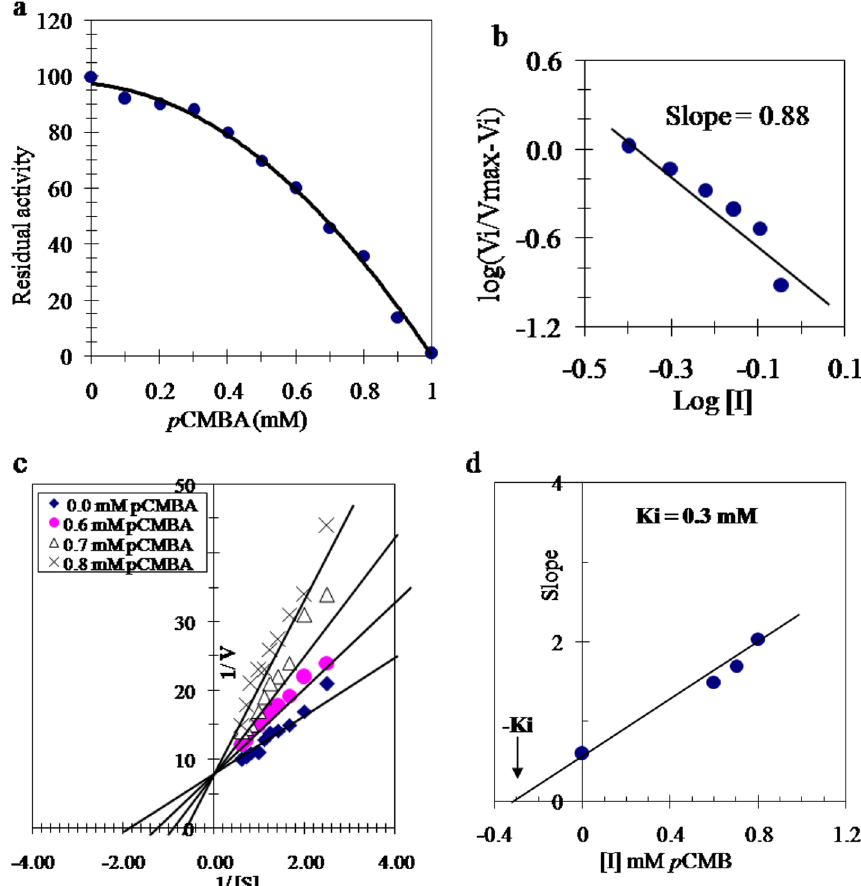
Fig. 4 a TLGST Inhibition with p CMB various concentrations. b Hill plot of TLGST inhibition with p CMB. c Lineweaver–Burk plots showing TLGST inhibition type with p CMB. d TLGST inhibition constant ( Ki ) value for p